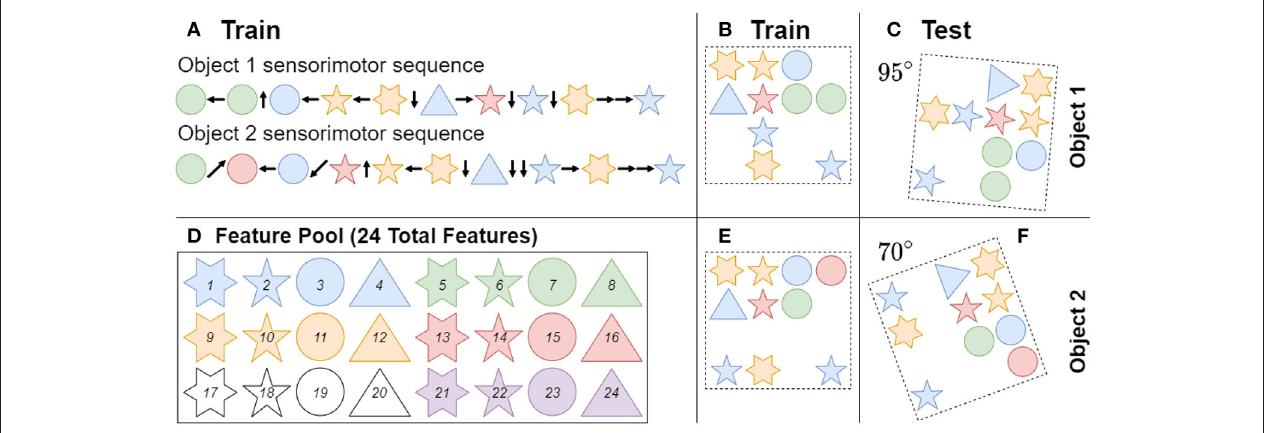
FIGURE 4 | Objects are composed of features sampled randomly from a fixed pool (D) with replacement, meaning that objects can share features with each other. Note the shape and color of features only act as a visual aid to show feature uniqueness. Each object is built from 10 features at random locations in a four-by-four grid. Object 1 and object 2 are examples of this process, and were trained in their original orientations (B,E) . (A) During training the network visits each feature in an object once in a random order, by receiving a sensorimotor sequence. (C,F) During inference the network is tested on a randomly ordered sensorimotor sequence from a learned object that has been rotated in a random orientation. When there is no unique feature in an object, the network has to utilize path integration to identify objects through the relative locations of their respective